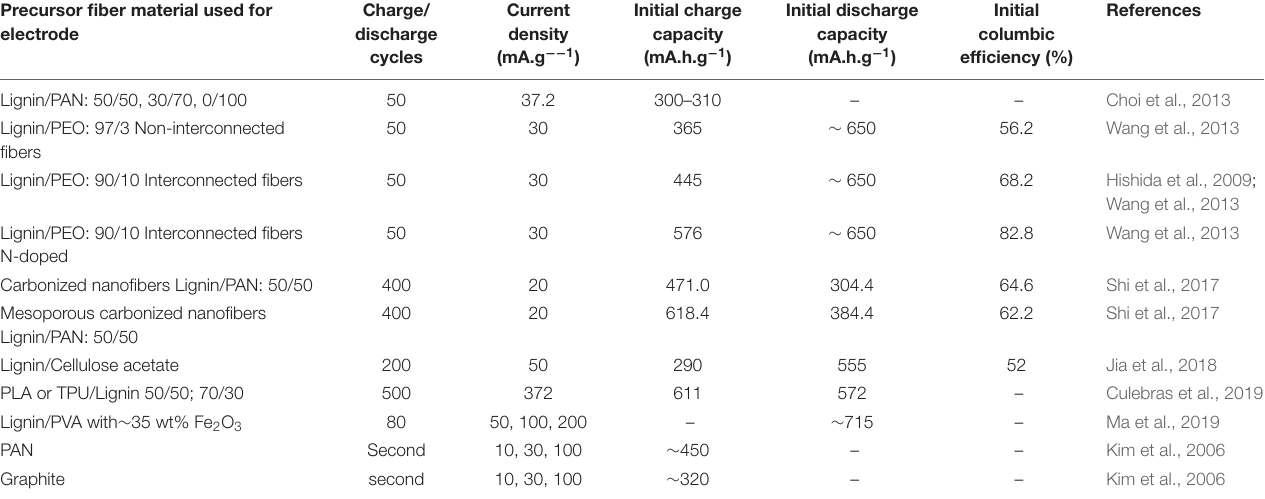
TABLE 3 | Electrochemical properties of carbonized fibers as lithium-ion battery anodes. Precursor fiber material used for electrode